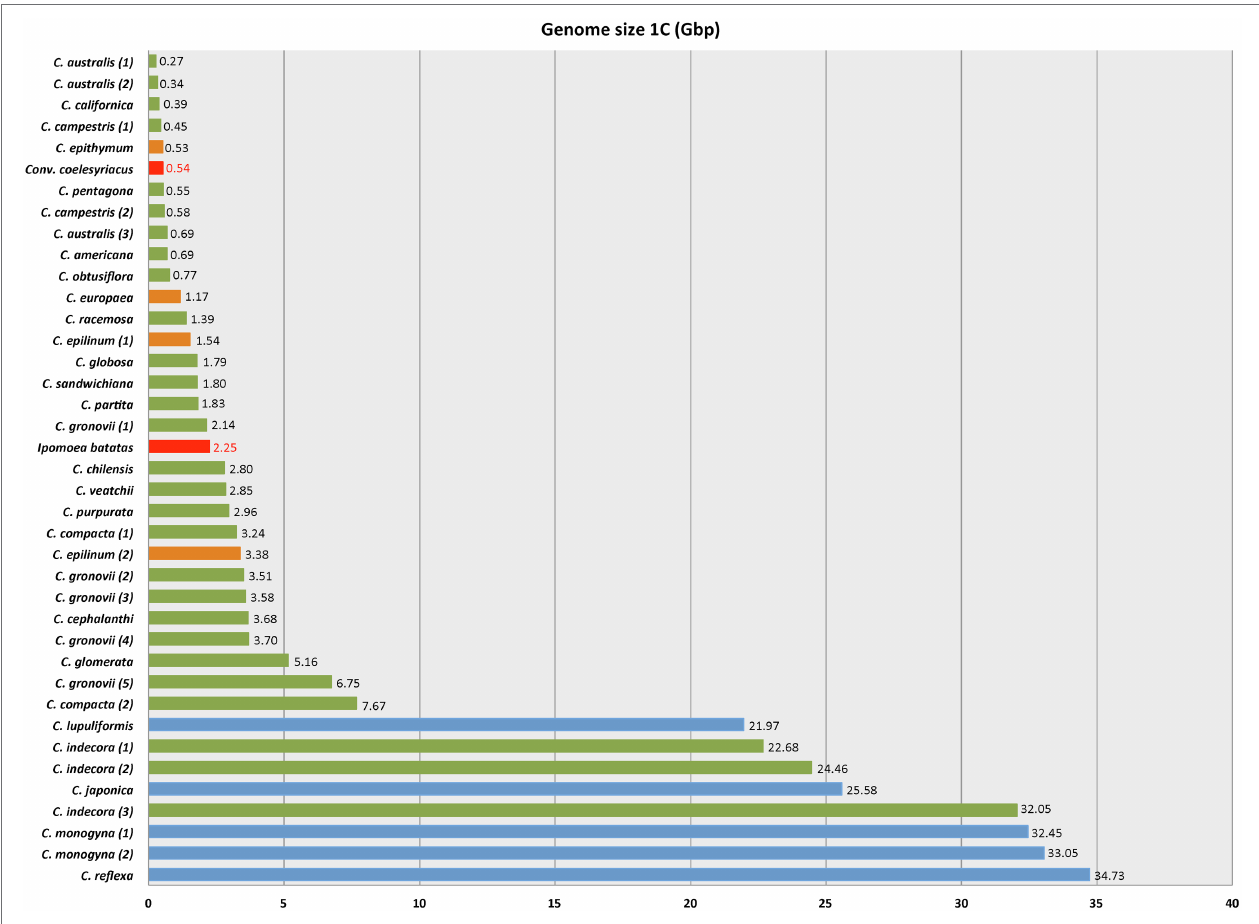
FIGURE 3 | Genome size variation in Cuscuta based on the data in Table 2 . Red bars indicate the lowest and highest known genome sizes in other Convolvulaceae, as reported in the Plant DNA C-values Database (https://cvalues.science.kew.org/). Color bars for Cuscuta indicate the subgenera: blue for Monogynella , green for Grammica, and orange for subgenus